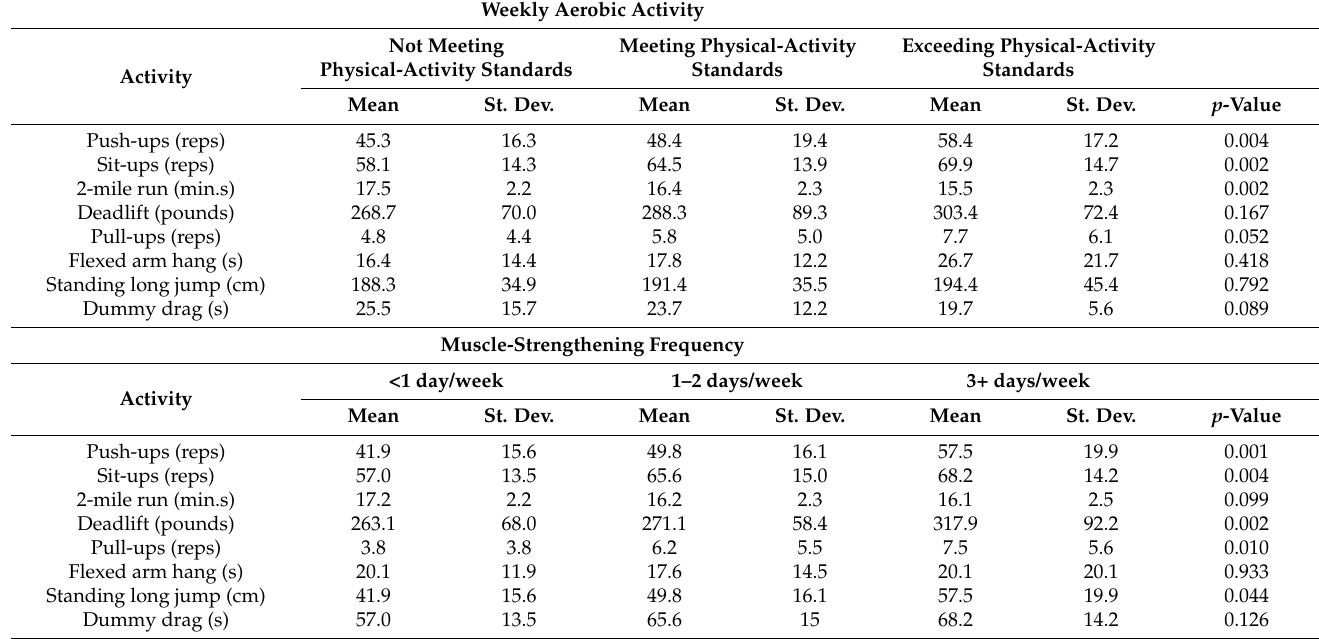
Table 3. Comparison of fitness test performance by physical activity